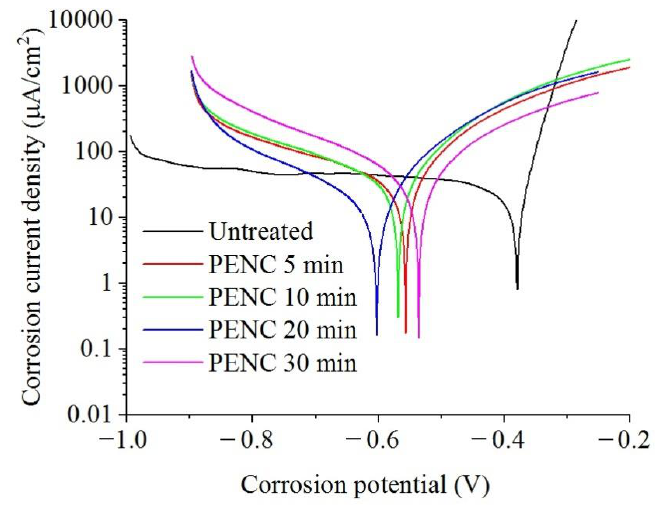
Figure 10. Polarization curves of the untreated and PENC